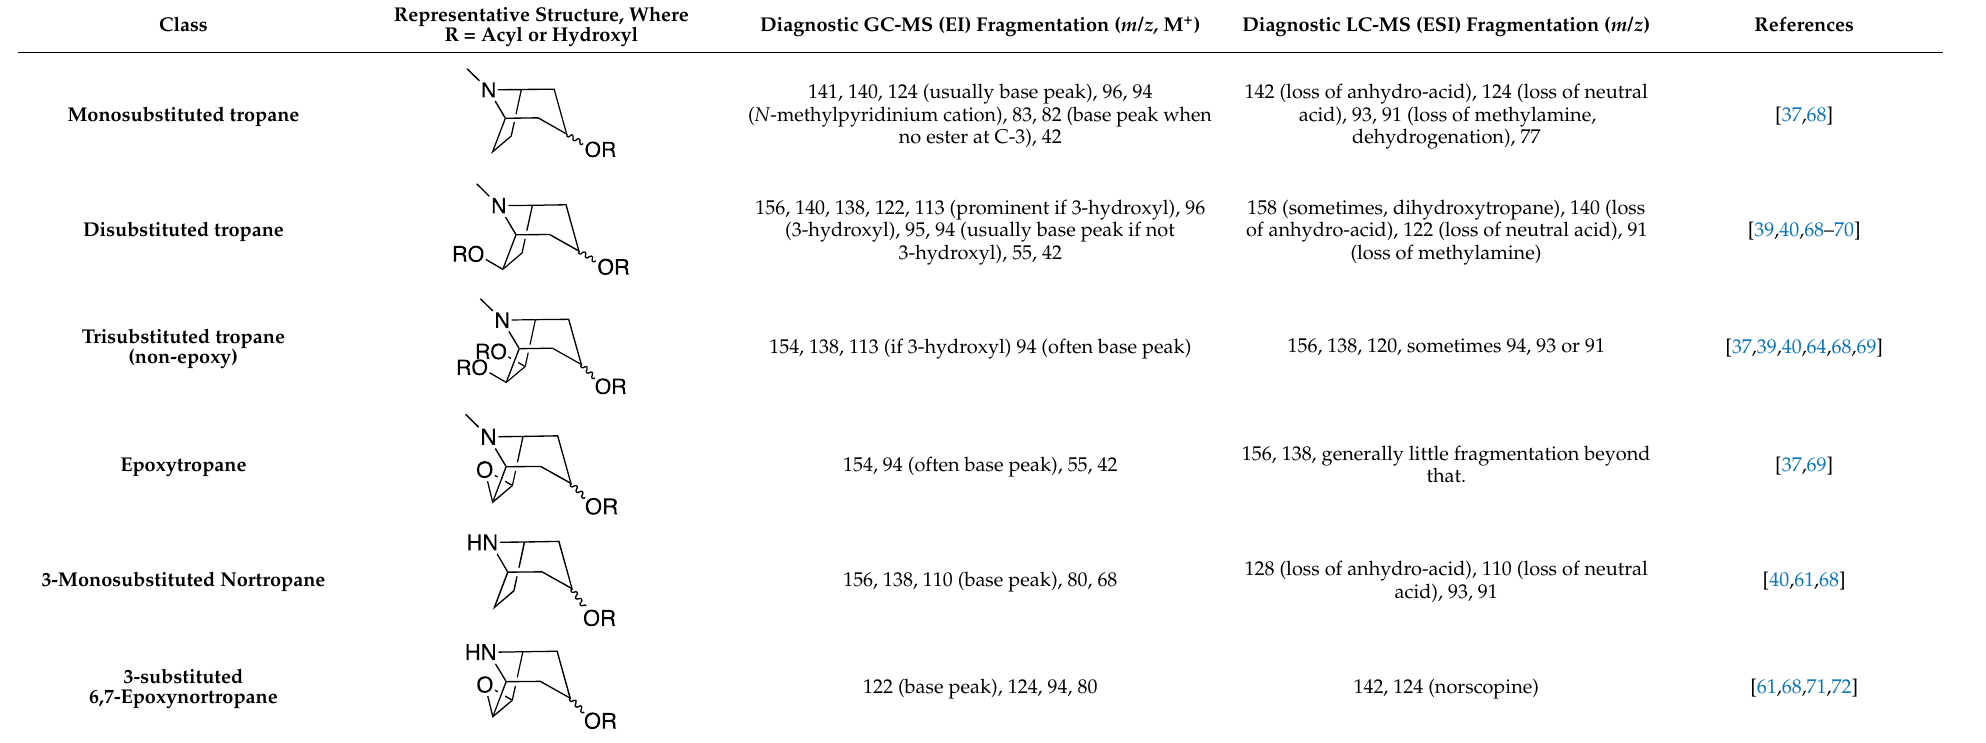
Table 1. Comparison of tropane and pyrrolidine alkaloid fragment ions obtained by GC-(EI) and LC-(ESI)-MS.